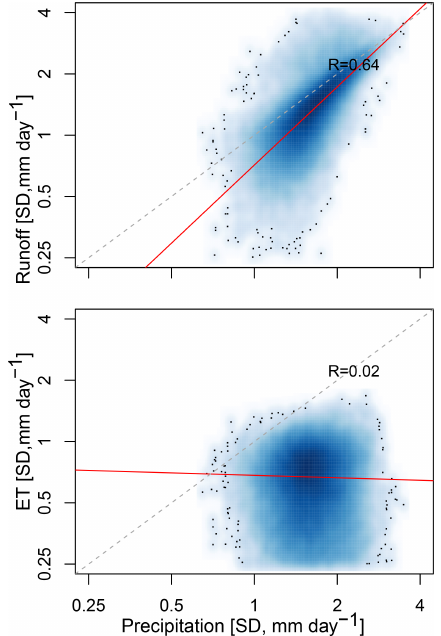
Figure 3. Propagation of precipitation uncertainty into the runoff and ET simulations. Standard deviations (SDs) are computed across the precipitation estimates and the resulting runoff and evapotran- spiration values. This is done at every grid cell and for every month between May and September. Red lines indicate linear regression lines. Note that a log–log scale is